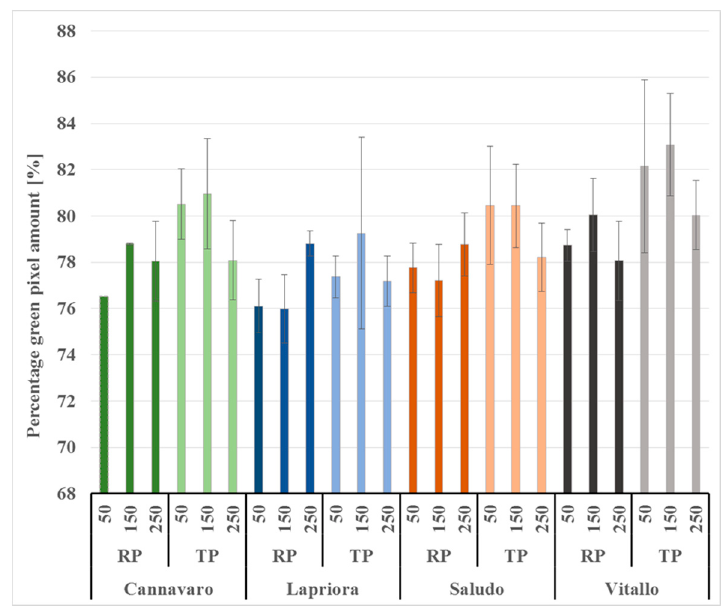
Figure 5. Ground cover of four different cultivars at the BBCH 13–15 development stages. Segmentation of the percentage of green pixel amounts (%) for different nitrogen application levels (50, 150 and 250 kg N ha − 1 ) and different planting systems, row planting.